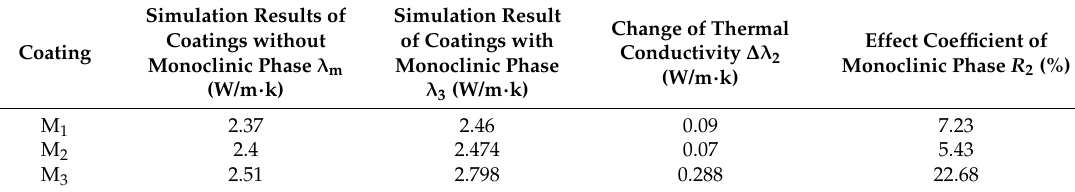
Table 7. The simulation results λ m , λ 3 and the effect coefficient R 2 .